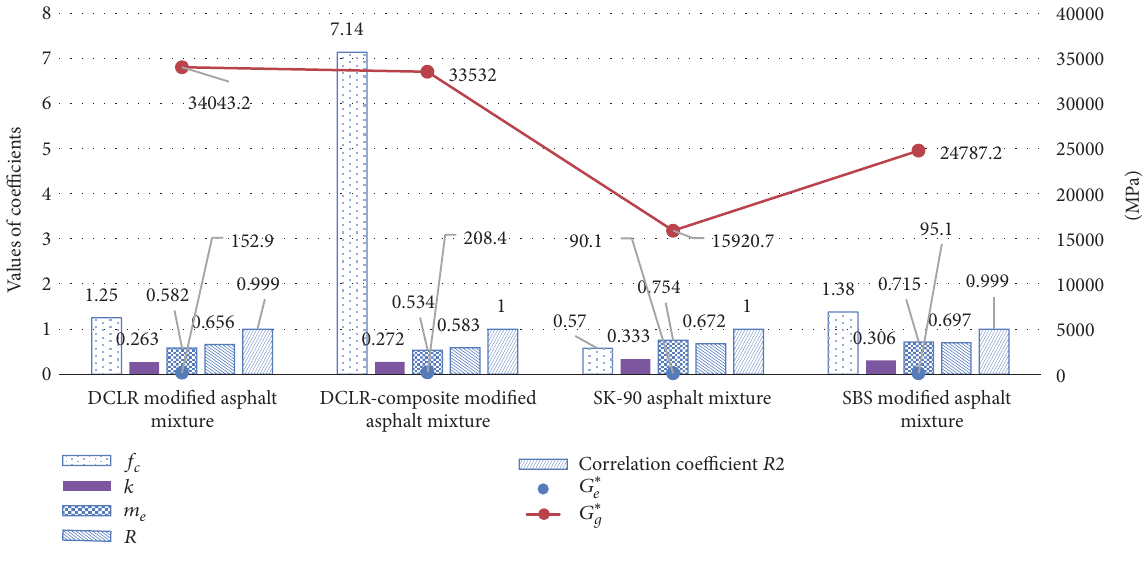
Figure 8: Viscoelastic parameters of the CAM